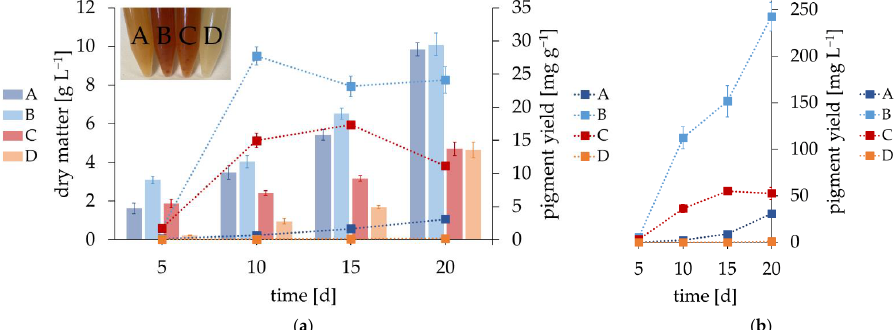
Figure 1. ( a ) Productivity of different L. sulphureus strains regarding biomass (bars, left ordinate) and pigment yield (squares, right ordinate) in shake flask culture. Insert on the top left side: A picture of the unprocessed cultures (biomass and supernatant) on cultivation day 15 with visible color differences. ( b ) Total pigment yield per culture volume over the course of cultivation.